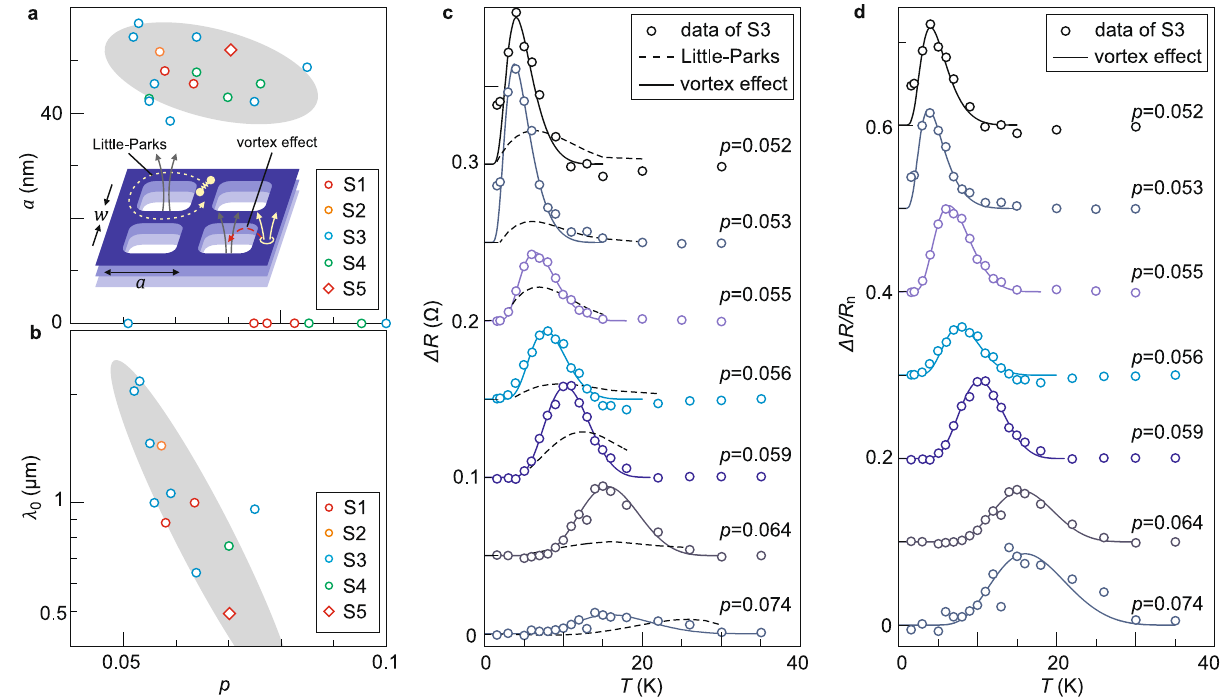
Fig. 4 Quantitative analysis of the Little-Parks like resistance oscillations. a Extracted spatial period as a function of doping for different samples. Inset schematically illustrates the Little-Parks effect and the vortex effect in a periodic superconducting array. The colored mesh indicates the superconducting region. The empty squares indicate the non-superconducting region. b Penetration depth extracted by fi tting the temperature dependent oscillation amplitude. c oscillation amplitude as a function of temperature Δ R T ð Þ at different doping levels for sample S3. They are obtained by calculating the absolute difference between the local and nearest-neighboring maximum and minimum in the Δ R B ð Þ traces ( B 2 1,4 T) at each p and T . Dashed curves are the expected oscillation amplitudes according to the Little-Parks effect. Solid curves are the theoretical fi ts by taking into account the vortex effect [Eq. (1)]. Data points and curves are vertically offset by 0.05 Ω for clarity. d same data sets as shown in c but normalized by the normal state resistance R n . They are vertically offset by 0.1 for